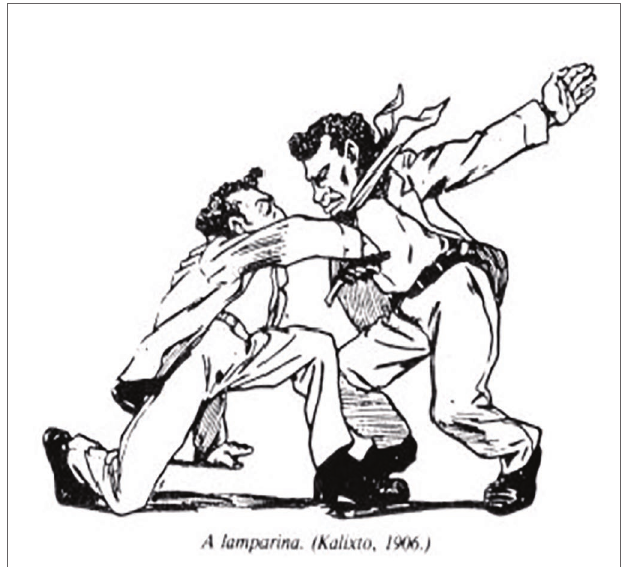
FIGURE 3 | The oil lamp.